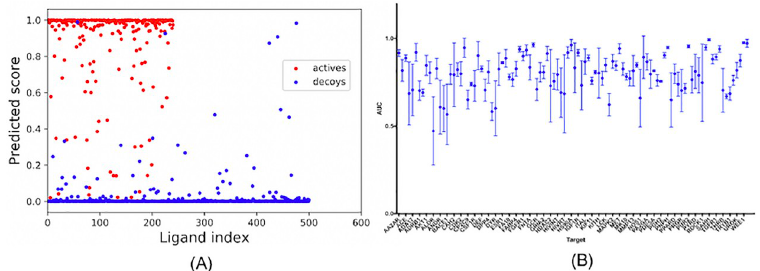
Fig 8. Actives and decoys are generally distinguishable for DUD-E targets. (A) The prediction score of actives and decoys in AA2AR as a representative example; (B) Performance of ligand-trained CNN models trained on small sets of five actives and five decoys. The dots represent mean values, and the bars represent standard deviation.